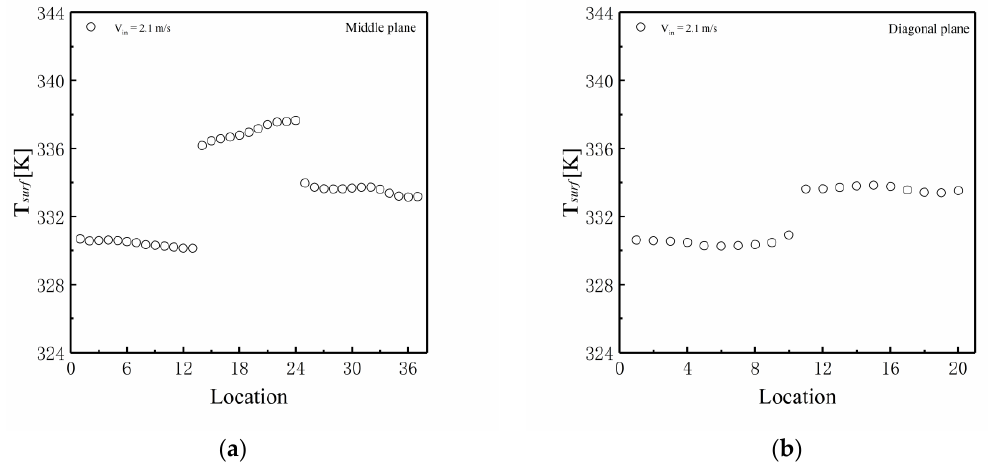
Figure 7. Pebble surface temperature under an inlet velocity of 2.1 m/s at ( a ) the middle plane and ( b ) the diagonal plane.